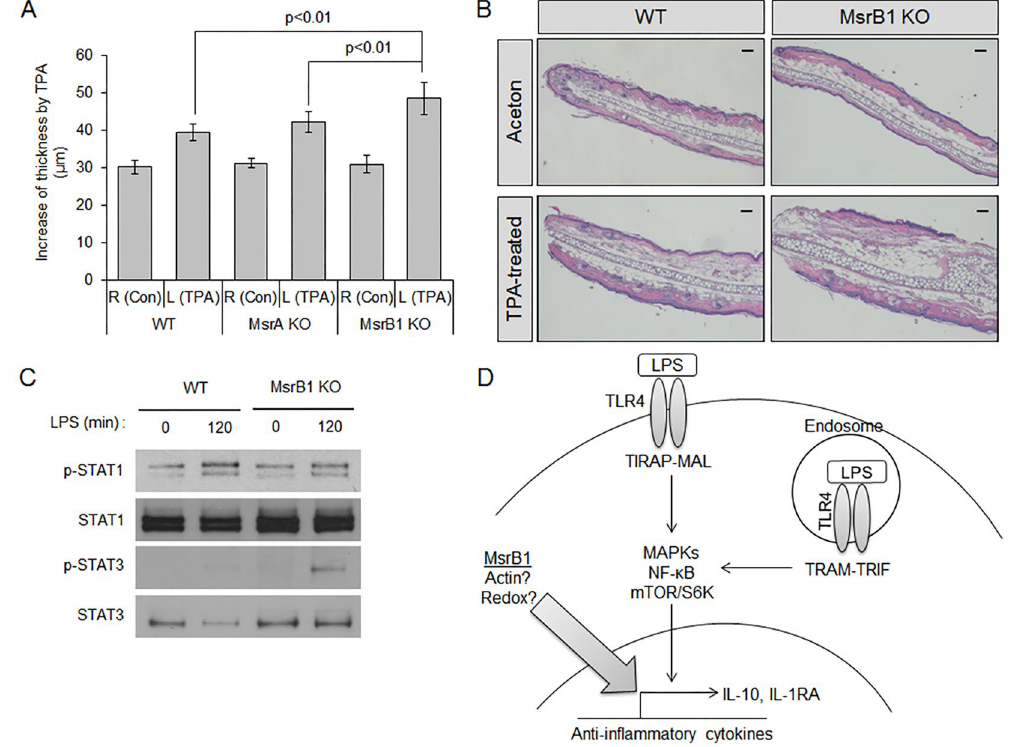
Figure 6. Increased inflammatory responses in TPA-irritated skin of MsrB1-KO mice. ( A ) Skin swelling in TPA-treated left auricles (L) and acetone-treated right auricles (R) was quantified twenty-four hours after irritation (n = 10). Error bars represent standard deviation. Data were statistically analyzed by Student’s t-test ( p < 0.01). ( B ) Histological features of acetone- and TPA-treated aurticular skin from WT and MsrB1 KO mice were visualized by H&E staining and microscopy (Scale bar = 100 µ m). Images are representative of three mice for each treatment group. ( C ) Western blot analysis of STAT1 and STAT3 phosphorylation in WT and MsrB1 KO BMDMs after the indicated duration of LPS stimulation. Cropped gel images are shown and full images are included in Supplementary Figure S3. ( D ) Scheme of MsrB1 function in TLR4 signaling and TLR4-induced IL-10 and IL-1RA